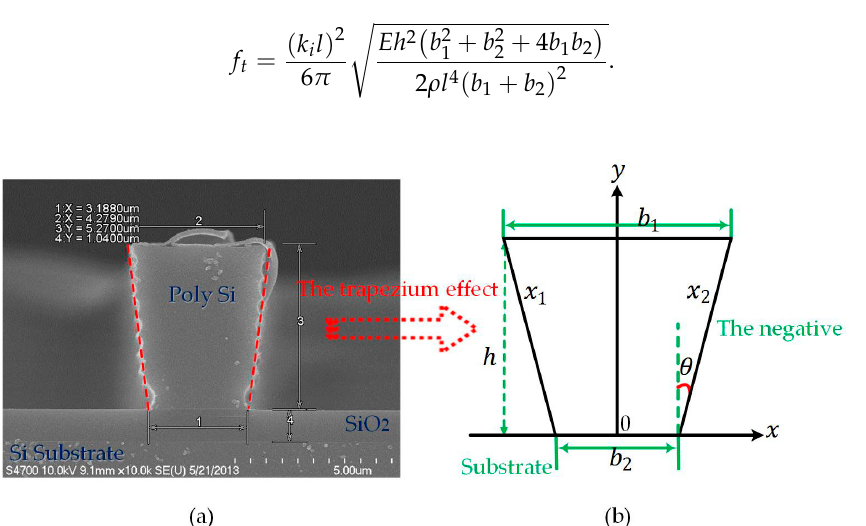
Figure 3. The trapezium effect of a doubly-clamped beam: ( a ) SEM side-view, fabricated by the Bosch process and un-released; ( b ) the coordinate sketch-map for the negative.